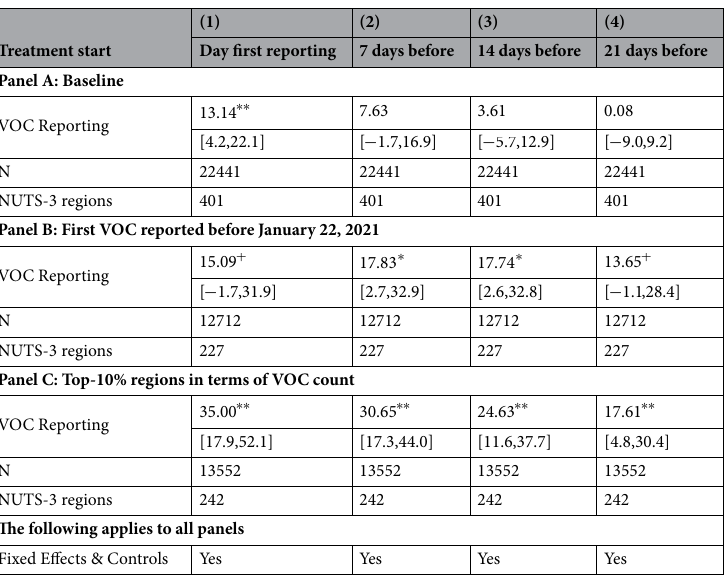
Table 1. Difference-in-difference estimations for association between first reporting of variants of concern (VOC) and 7-day incidence rates at the local area level in Germany. Across columns, the dependent variable is the 7-day incidence rate in a NUTS-3 region at a given day. We always consider the time period between November 15, 2020 and February 4, 2021. In Panel A, we take into account all 401 NUTS-3 regions in Germany. By February 4, 2021, 204 NUTS-3 regions reported a VOC case and 197 did not (Panel B: 30 NUTS-3 regions with at least one reported VOC case before January 22, 2021; Panel C: 45 NUTS-3 regions belonging to the top 10% of sample regions in terms of VOC count). In Panel A, VOC Reporting is a dummy variable defined as one if a VOC case has been reported in a NUTS-3 region, else zero (Panel B: VOC Reporting is one if a VOC case has been reported before January 22; Panel C, VOC Reporting is one if a regions belongs to the top-10% regions in terms of VOC count). Some observations have been dropped because we lack information on some control variables (e.g., on Daily mobility change in relation to 2019 for December 4–7, 2020). We include NUTS-3 and day fixed effects and a linear and a squared trend for four different NUTS-3 region types. We also control for a 1 day, a 7-days and a 14-days lag of the following variables: first, the reported SARS-CoV-2 cases within the previous 7 days, second, the reported SARS-CoV-2 cases within the previous 7 days in neighboring NUTS-3 regions, third, the daily mean temperature at 2 m above ground in ◦ C , and fourth, the daily mobility change in relation to 2019. We include (but do not show) a constant in all regressions. 95% confidence interval based on clustered SE (on NUTS-2 level) in parentheses; + p < 0.1 , 0.05 , 0.01 ∗ p < ∗∗ p <